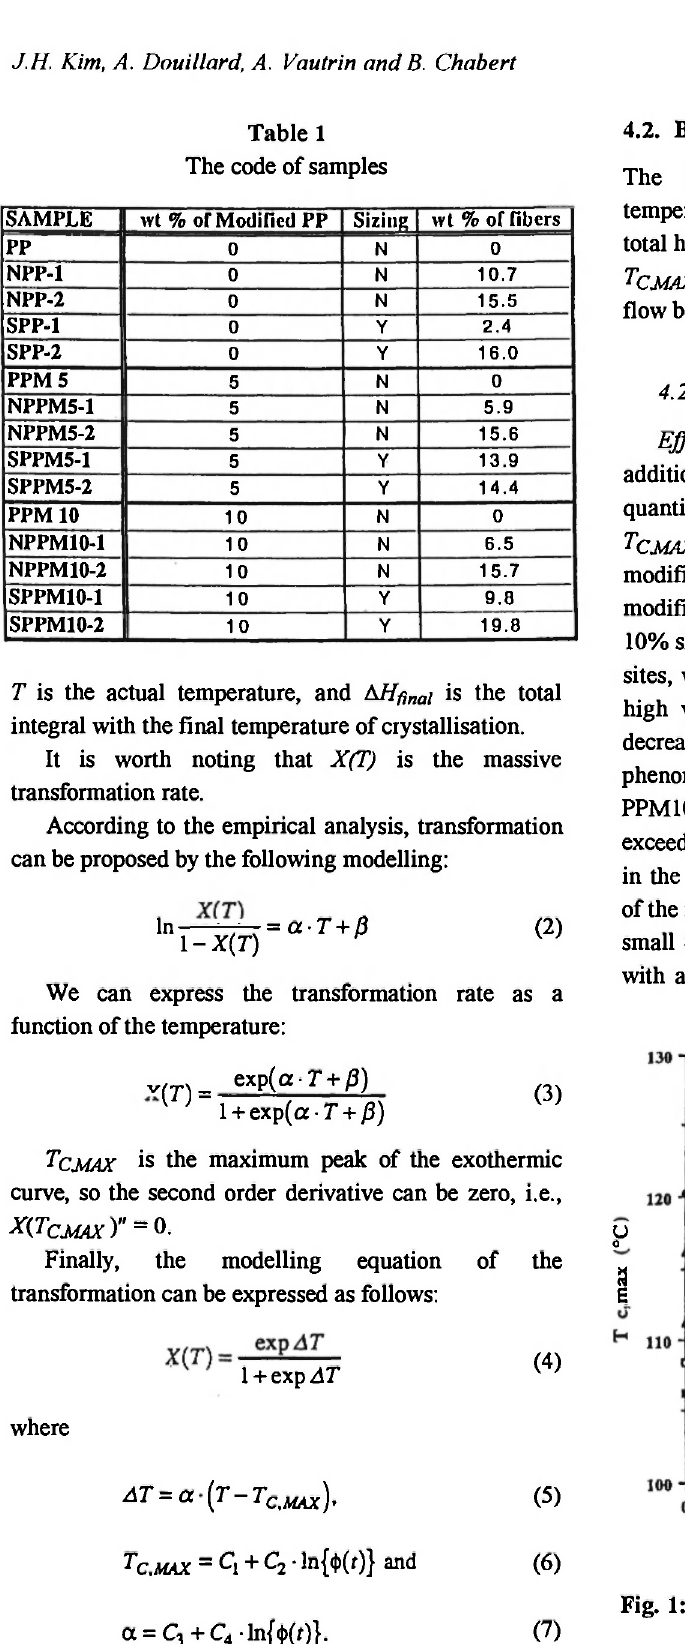
Fig. 1: Trends of TCMAX of the matrix as a function of the modified PP and the cooling